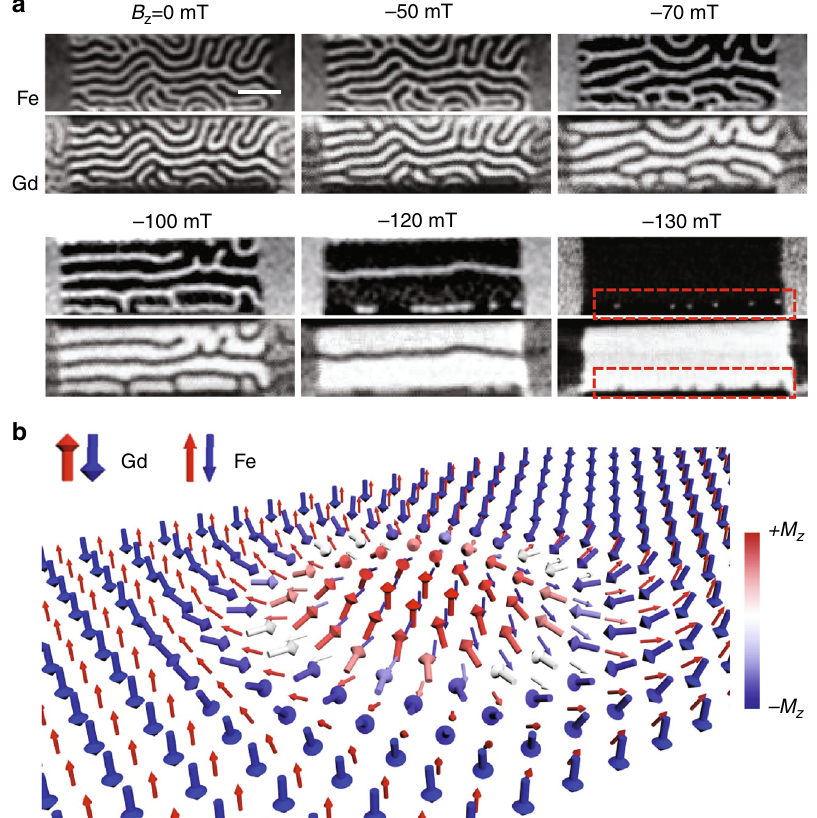
Fig. 1 Scanning transmission X-ray microscopy (STXM) imaging of domain structure upon magnetic fi eld application. a STXM images acquired by sweeping the external perpendicular magnetic fi eld from B z = 0 mT to B z = − 130 mT. Dark and bright contrasts correspond to magnetization oriented up (along + z ) and down (along − z ), respectively. Upper panel and lower panel show corresponding images acquired at the L 3 and M 5 absorption edges of Fe and Gd, respectively. Note that, due to longer penetration depth associated with the higher energy used for Gd, ~1189 eV, compared with that of Fe, ~709 eV, magnetic contrast under Au electrodes is visible for Gd magnetic moment imaging. b Schematic of antiferromagnetically exchange-coupled ferrimagnetic skyrmion on a magnetic track as observed in our GdFeCo fi lms as indicated in the red dashed-square boxes in the last image of a . Scale bar, 1